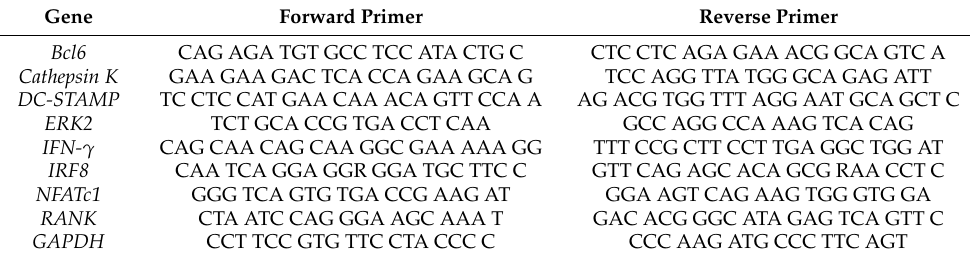
Table 1. List of qRT-PCR primer